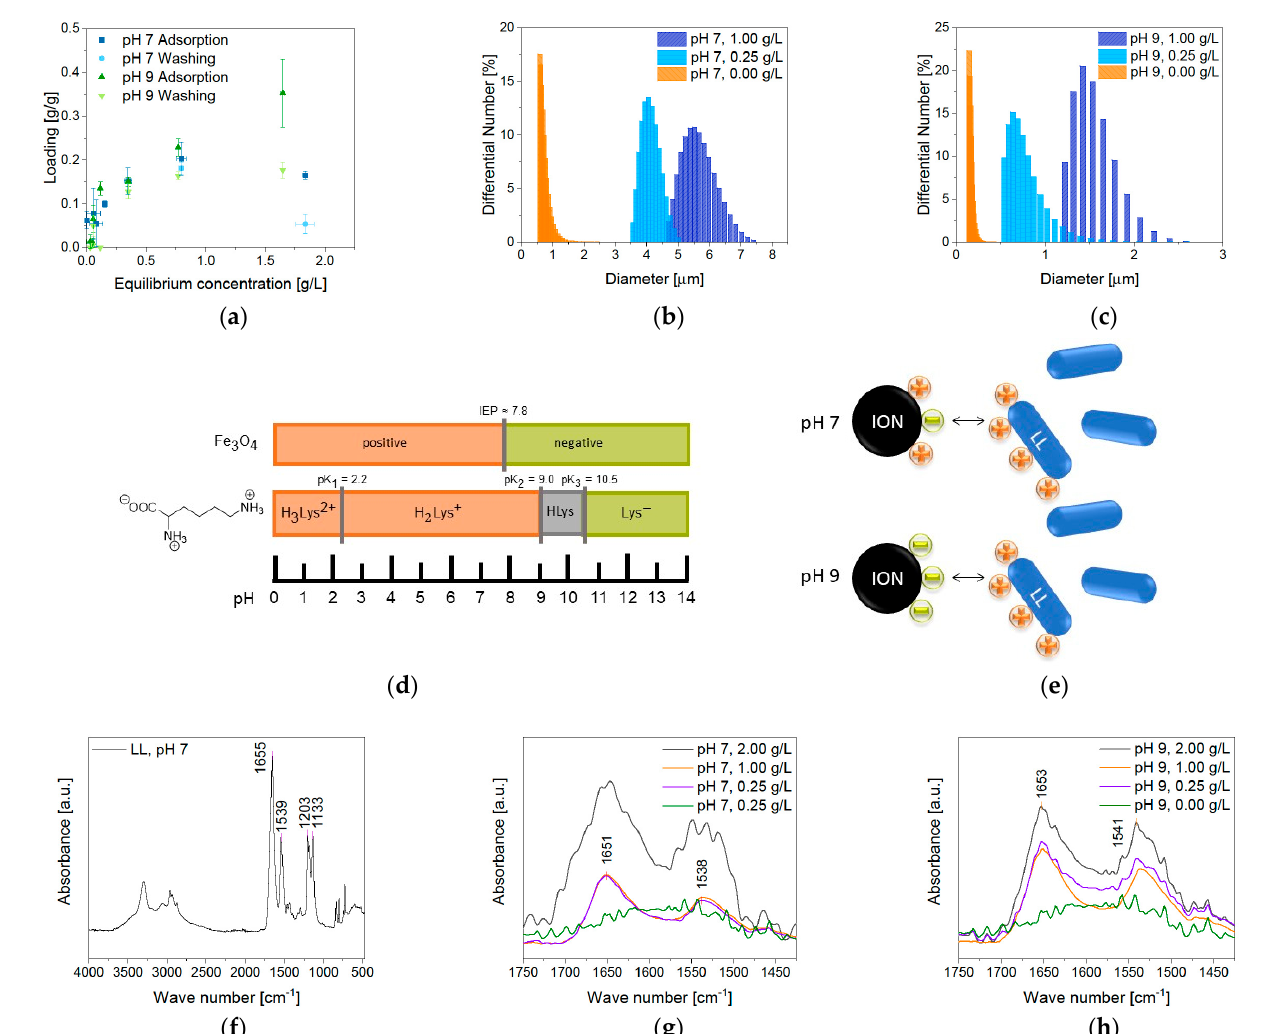
Figure 4. ( a ) Adsorption isotherms of LL at pH 7 and 9 in water and 1 g/L of BIONs, ( b ) hydrodynamic diameters after LL adsorption at pH 7 and ( c ) pH 9 in water, ( d ) illustration of the BION and lysine charge in dependence on the pH. Reprinted with permission from J. Phys. Chem. C 2015, 119, 40, 23032–23041. Copyright 2015 American Chemical Society [22,45], ( e ) interaction of BIONs with lasioglossin at pH 7 (top) and pH 8 (bottom) and IR spectra of ( f ) lasioglossin at pH 7, ( g ) MNP@LL complexes at pH 7 and ( h ) at pH 9 with different starting peptide concentrations.